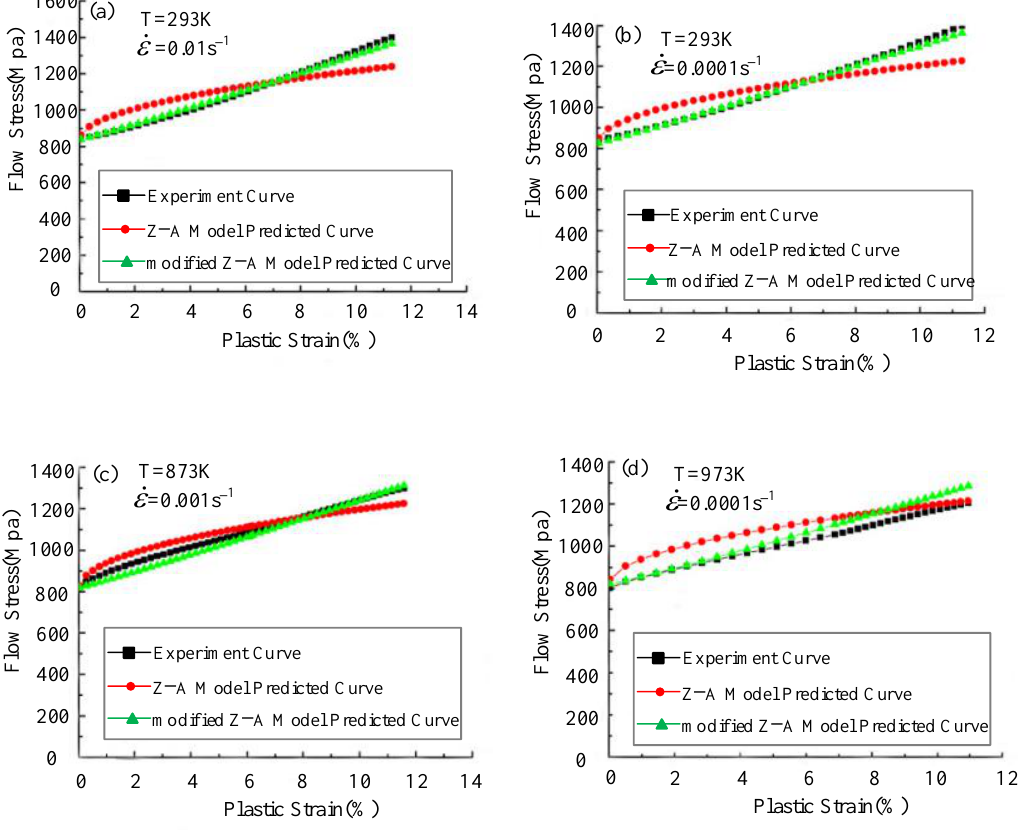
Figure 16. The prediction results of IC10 alloy based on the modified ZA model [40]. ( a ) T = 293 K, . . . ε = 0.001 s − 1 , ( b ) T = 293 K, ε = 0.0001 s − 1 , ( c ) T = 873 K ◦ C, ε = 0.001 s − 1 , ( d ) T = 973 K, ε = 0.0001 s − 1